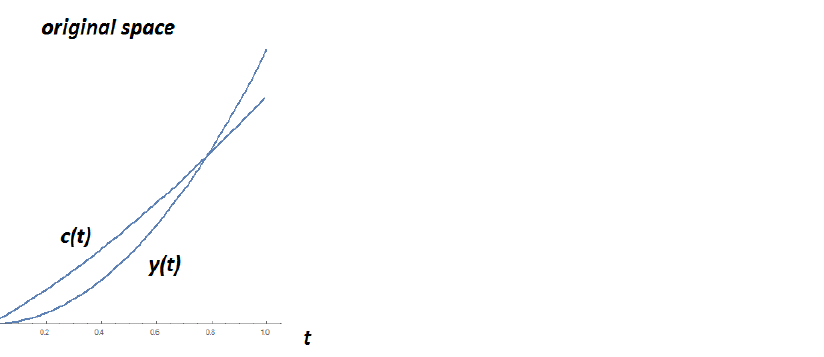
Figure 6. The original space with the curve y ( t ) and the image of the curve of curvature centers c ( t ) for γ = 0.6 .